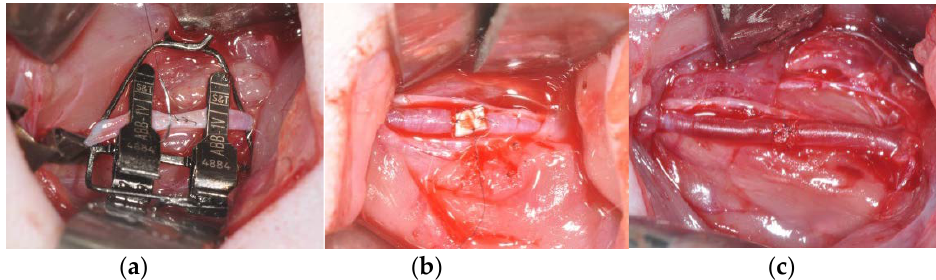
Figure 4. Repair of the artificial carotid artery defect: ( a ) direct closure of the artery defect as control group; patch angioplasty with ( b ) PTFE patch, and ( c ) 4-HR silk patch.